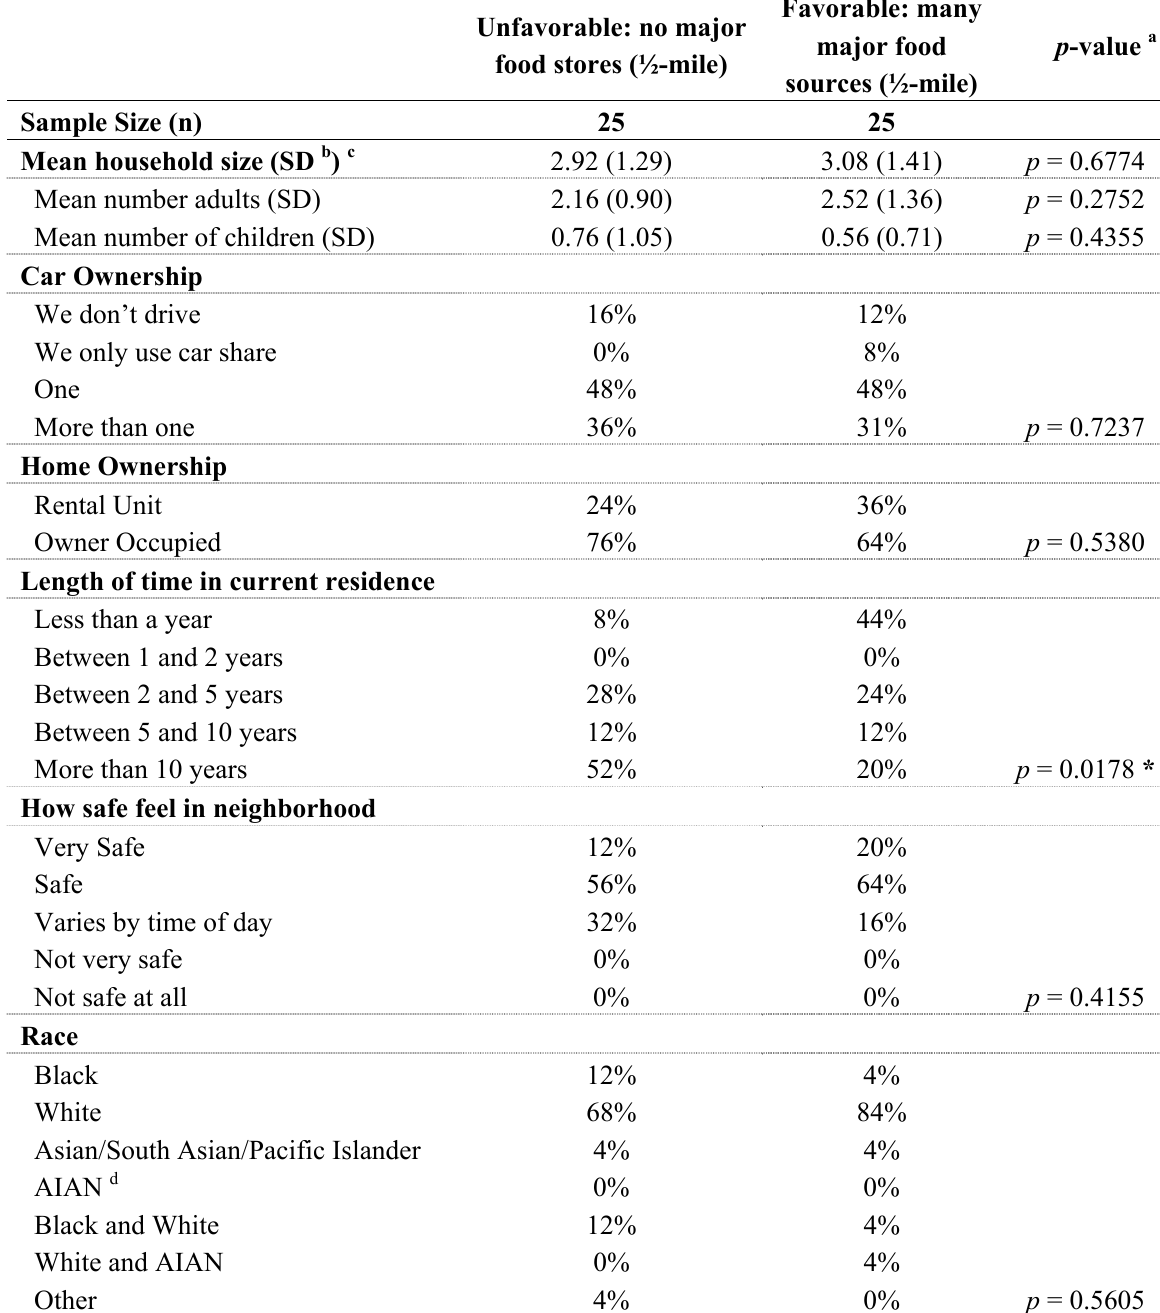
Table 1. Individual and household characteristics of participants by residential block and food environment (n =